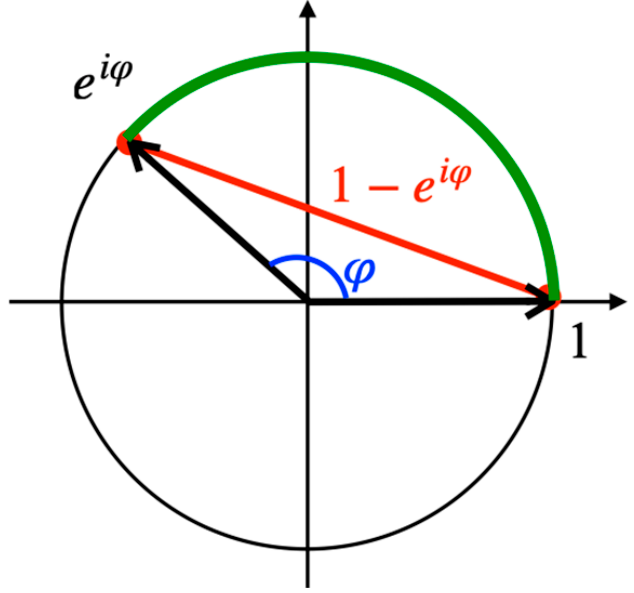
Figure 17. The length of a secant is smaller than the arc of the corresponding unit circle.